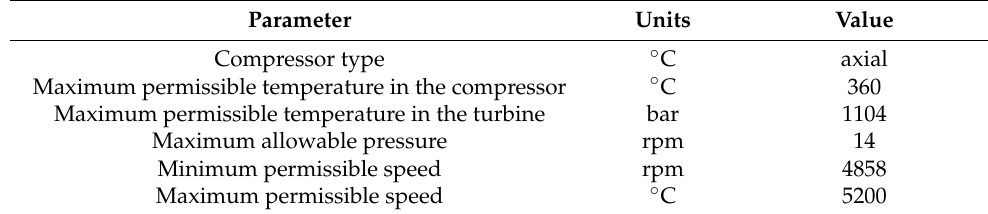
Table 1. Technological parameters of